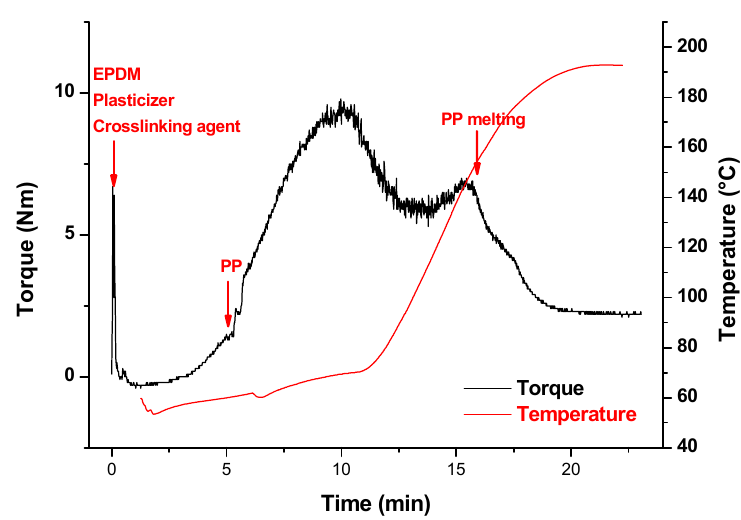
Figure 3. Mixing conditions of TPV in batch mixer. Variation of the torque and temperature versus mixing time. Formulation (phr): EPDM = 100, Oil Plasticizer = 122; PP = 75, DCP = 1. N = 50 rpm.